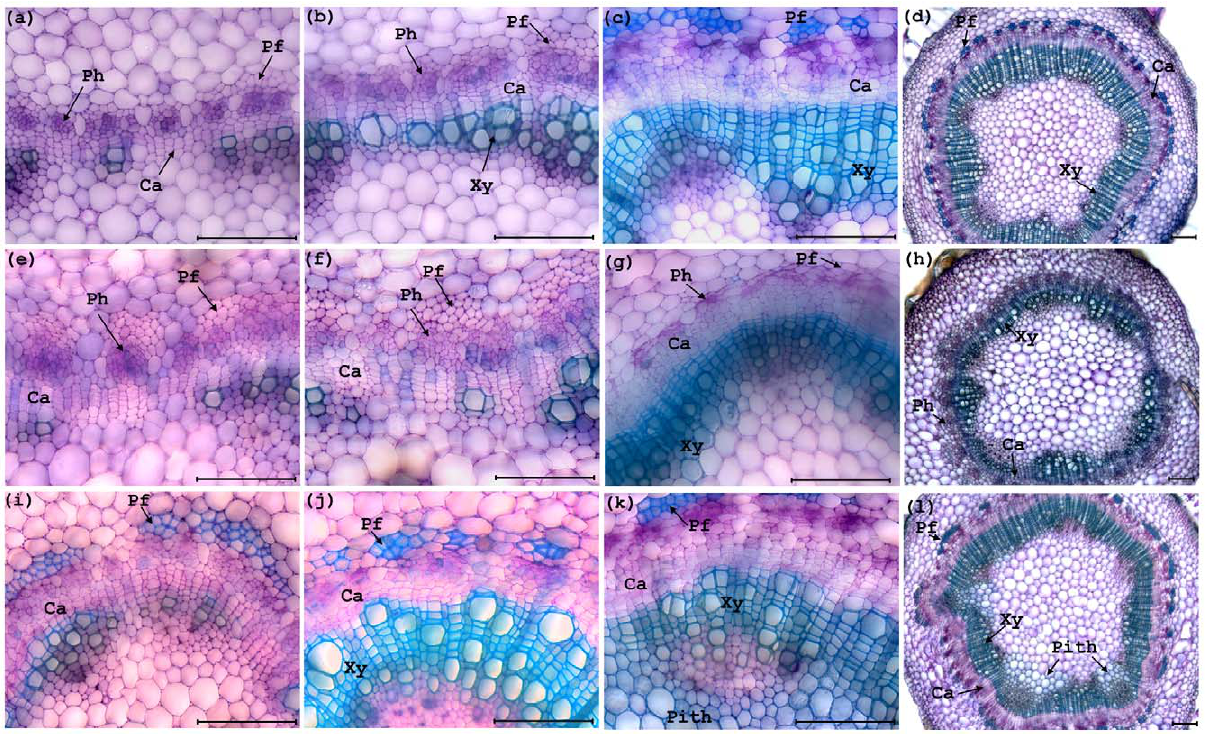
Figure 6. Transverse sections of stems from two month old wild-type and 35S::PCN-miRNAd gain of function and 35S::miRNA-PCN knockdown Populus . (a) Section from fourth internode of wild-type Populus stem during primary growth. (b) Section from seventh internode of wild-type Populus stem during transition to secondary growth, showing secondary xylem tissue formation. (c) Section from bottom internode of wild- type Populus stem showing secondary phloem fibers and secondary xylem tissue. (d) Lower magnification view of bottom internode of wild-type stem. (e) Section from fourth internode of 35S::PCN-miRNAd gain of function Populus stem during primary growth, showing increased cambium cell layers. (f) Section from seventh internode of 35S::PCN-miRNAd gain of function Populus stem during transition to secondary growth, showing delayed secondary xylem formation. (g) Section from bottom internode of 35S::PCN-miRNAd gain of function Populus stem showing no lignified phloem fibers formation and decreased xylem tissue. (h) Lower magnification of section from bottom internode of 35S::PCN-miRNAd gain of function Populus stem showing no lignified phloem fibers formation and decreased xylem tissue. (i) Section from fourth internode of 35S::miRNA-PCN knockdown Populus stem showing early formed lignified phloem fibers and xylem cells by comparing with the wild-type. (j) Section from seventh internode of 35S::miRNA-PCN knockdown Populus stem showing increased secondary phloem fibers and xylem tissue formation by comparing with the wild-type. (k) Section from bottom internode of 35S::miRNA-PCN knockdown Populus stem showing ectopic lignifications in pith cells. (l) Lower magnification of section from bottom internode of 35S::miRNA-PCN knockdown Populus stem showing ectopic lignifications in pith cells. Cambial zone (Ca), Phloem (Ph), Phloem fiber (Pf), Xylem (Xy), Bar=100 m m.